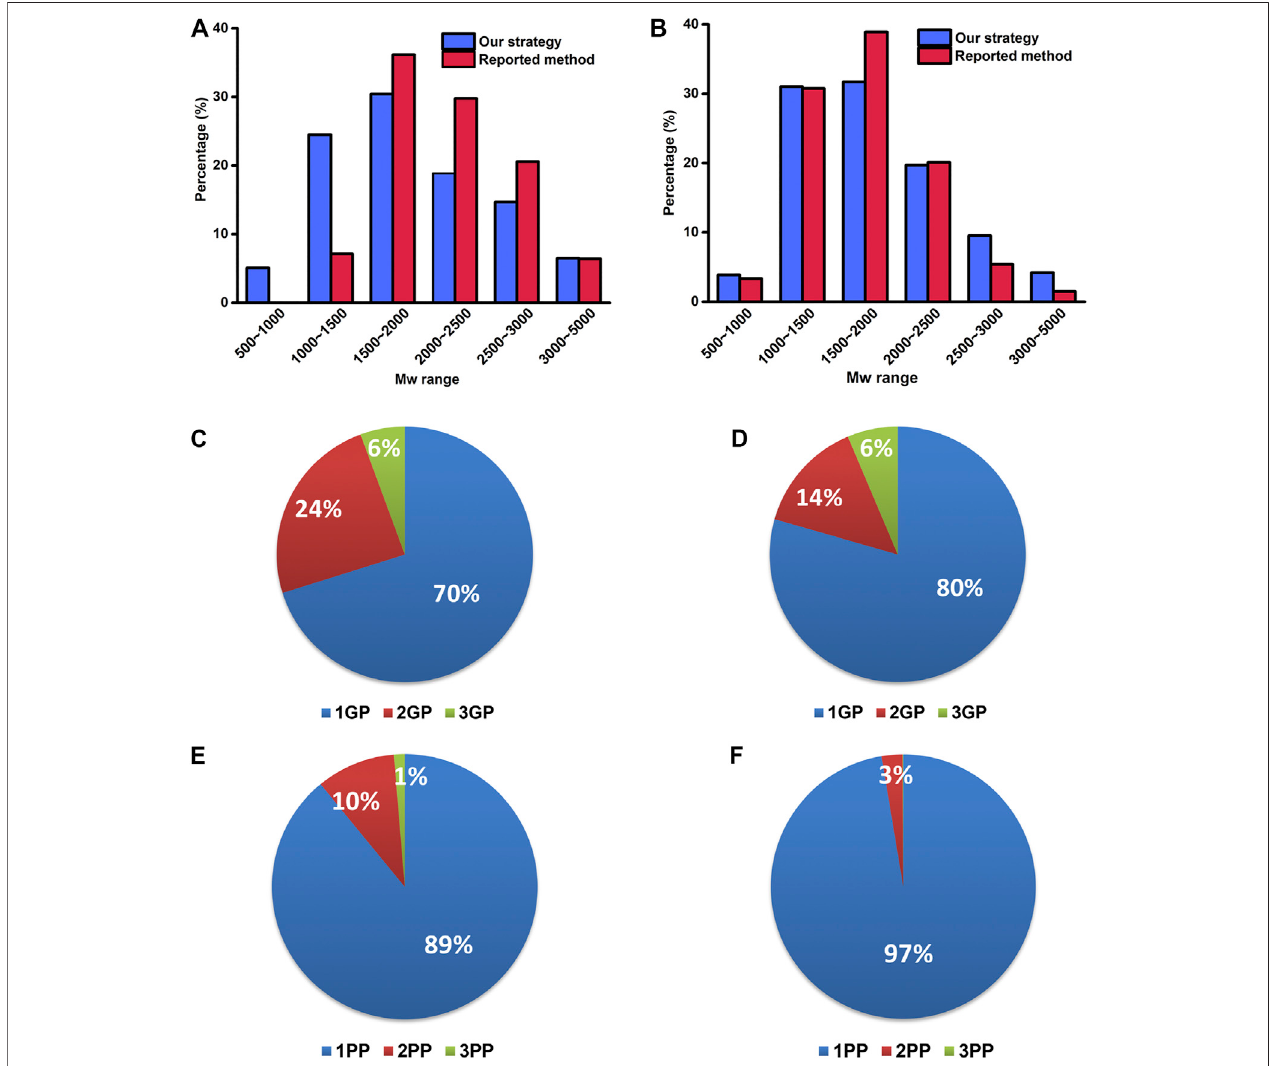
FIGURE5| TheMwdistributionofidenti fi edglyco- (A) andphosphopeptides (B) byourstrategyandthereportedmethod. Thepercentagesoftheidenti fi edPTM- peptides with single glycosylation/phosphorylation site and multiple glycosylation/phosphorylation sites by our strategy (C, E) and the reported method (D, F) . 1 – 3 GP: glycopeptide with 1 – 3 glycosylation sites; 1 – 3 PP: phosphopeptide with 1 – 3 phosphorylation sites.